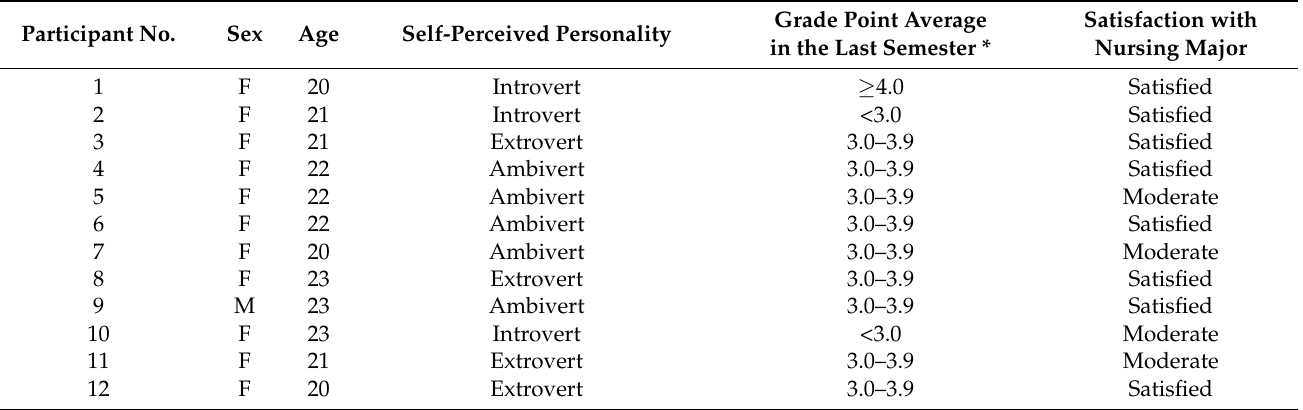
Table 3. General characteristics of participants (N = 12).